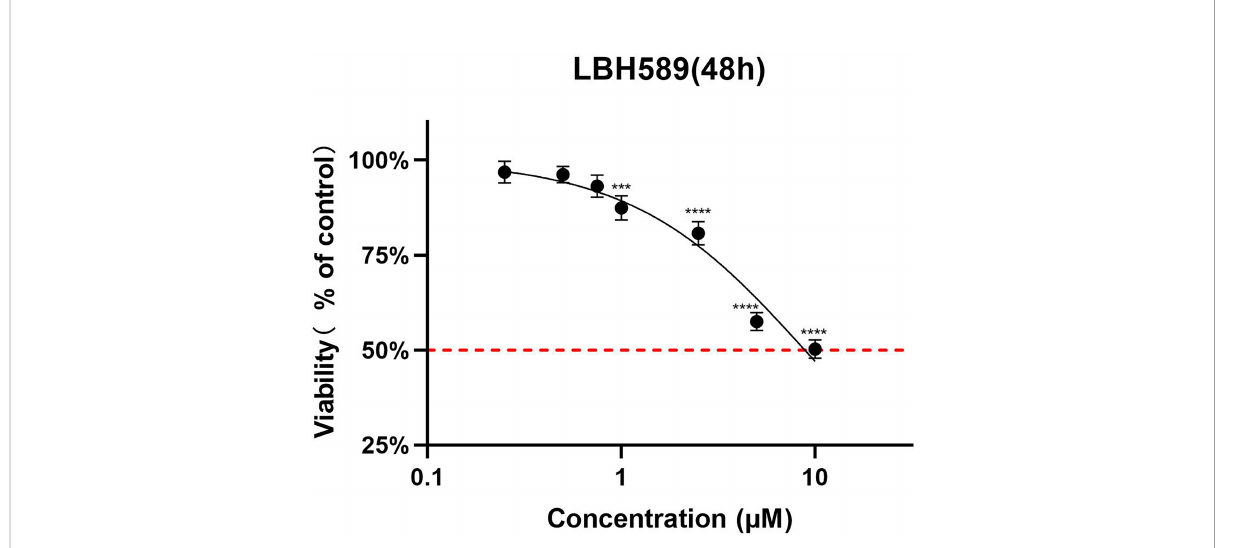
FIGURE 1 Cell toxicity assay of LBH589 on RPE cells for 48h of incubation. To determine a safe drug concentration in vitro , RPE cells were treated with different concentrations of drugs. RPE cells treated with DMEM were used as a control. Data are expressed as percent inhibition of cell viability relative to the control. **** P < 0.001, *** P < 0.0001 in comparison with the control. The experiment was repeated three times, with three wells of each